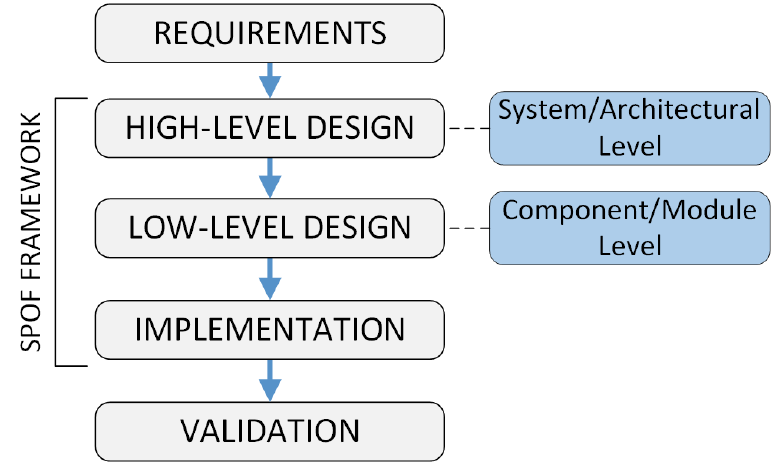
Figure 3. Reference Design